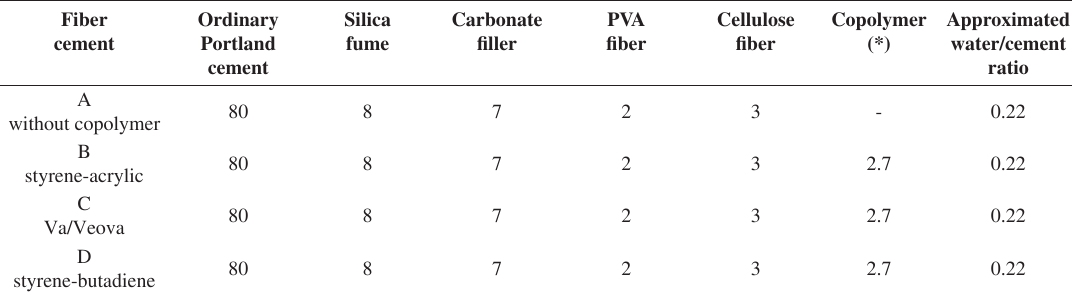
Table 7. Mixture proportions (% by mass).